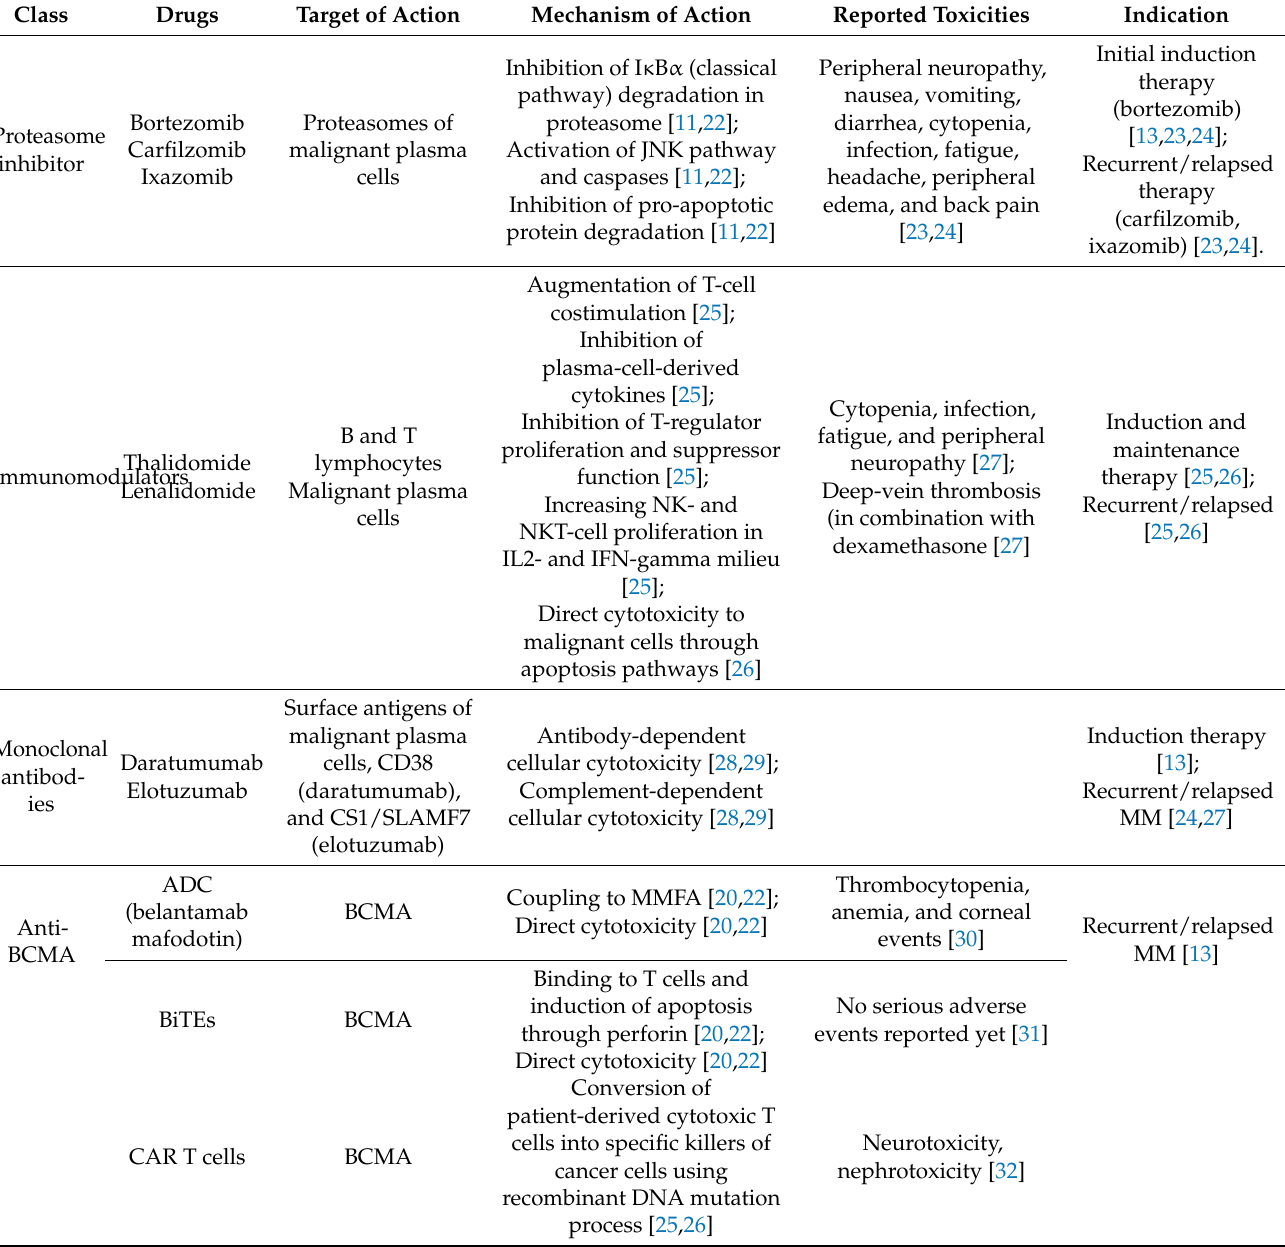
Table 1. Summary of MM